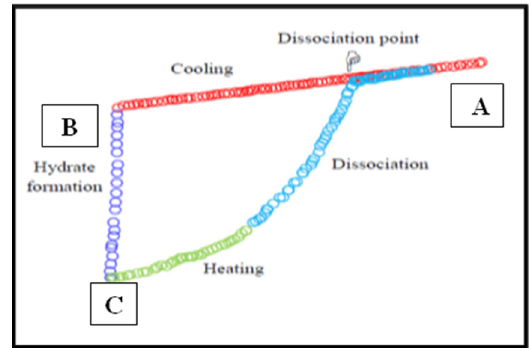
Fig. 2. Isochoric pressure search method [27].